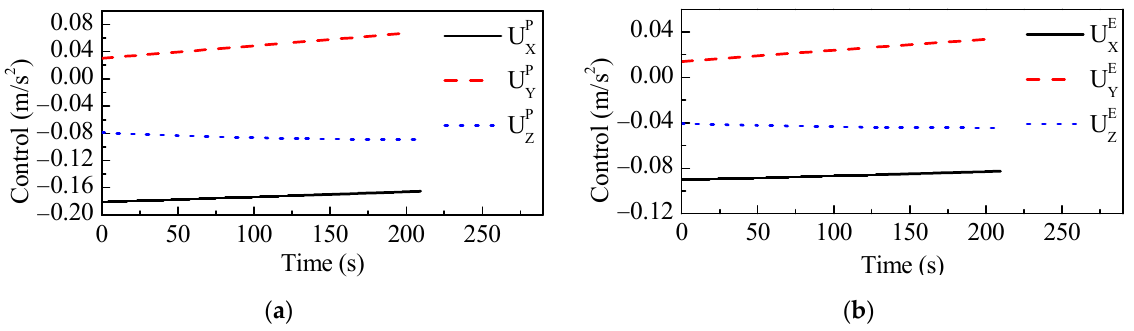
t changing with time. Figure 5. ( a ) t go and ( b ) ∆ t go changing with time. go